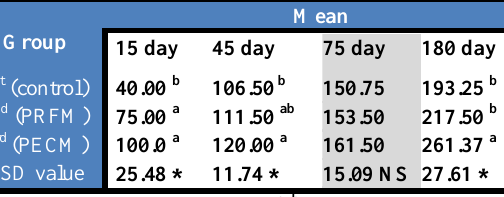
Table, 1: Mean values of tensile force test in goat.